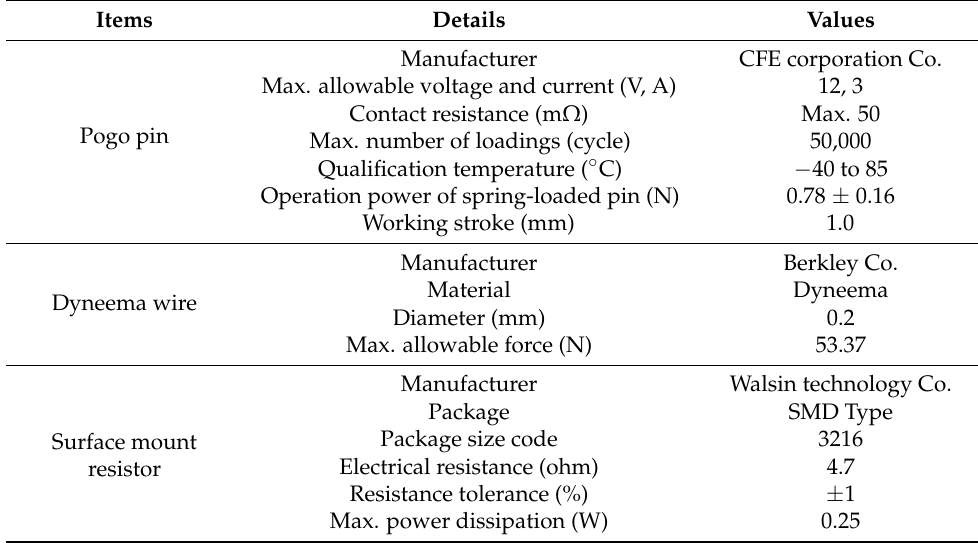
Table 2. Basic specifications of the hardware used in the